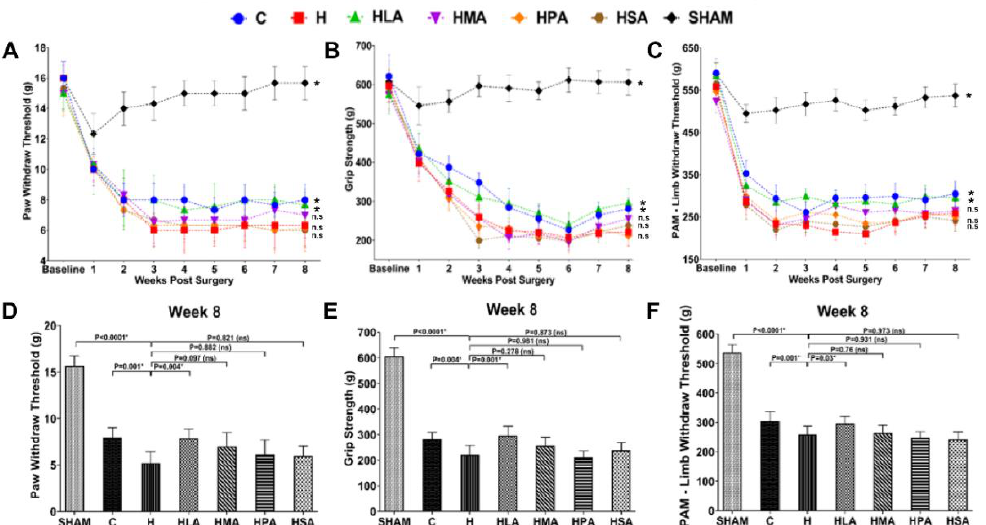
Figure 2. Evaluation of pain behaviour. Changes in the hind paw withdrawal threshold (A) , grip strength (B) and limb withdrawal threshold (C) in rats fed with different saturated fatty acid diets for a period of 8 weeks post-surgery. Week 8 changes in hind paw withdrawal threshold (D) , grip strength (E), and limb withdrawal threshold (F) in rats fed with the different saturated fatty acid diets. All values are represented as mean ± SD, n = 6. C, corn starch diet-fed rats; H, high-carbohydrate high-fat diet-fed rats; HLA, high-carbohydrate high-lauric acid diet-fed rats; HMA, high-carbohydrate high-myristic acid diet-fed rats; HPA, high-carbohydrate high-palmitic acid diet-fed rats; HSA, high-carbohydrate high-stearic acid diet-fed rats.